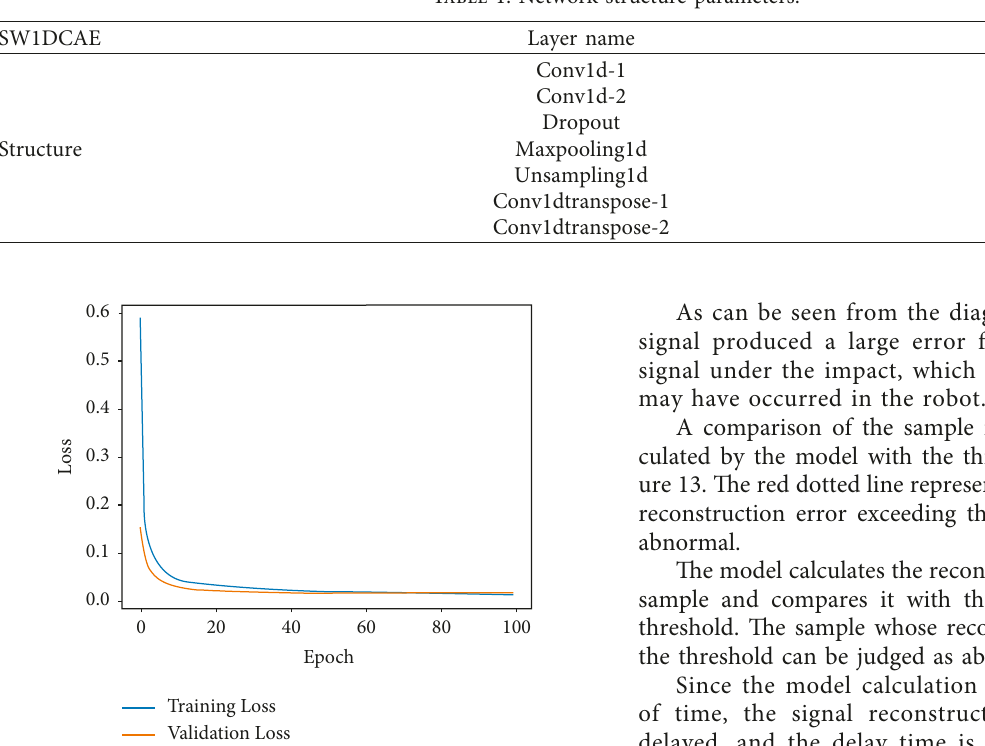
Figure 10: Loss variation in the training and validation sets.